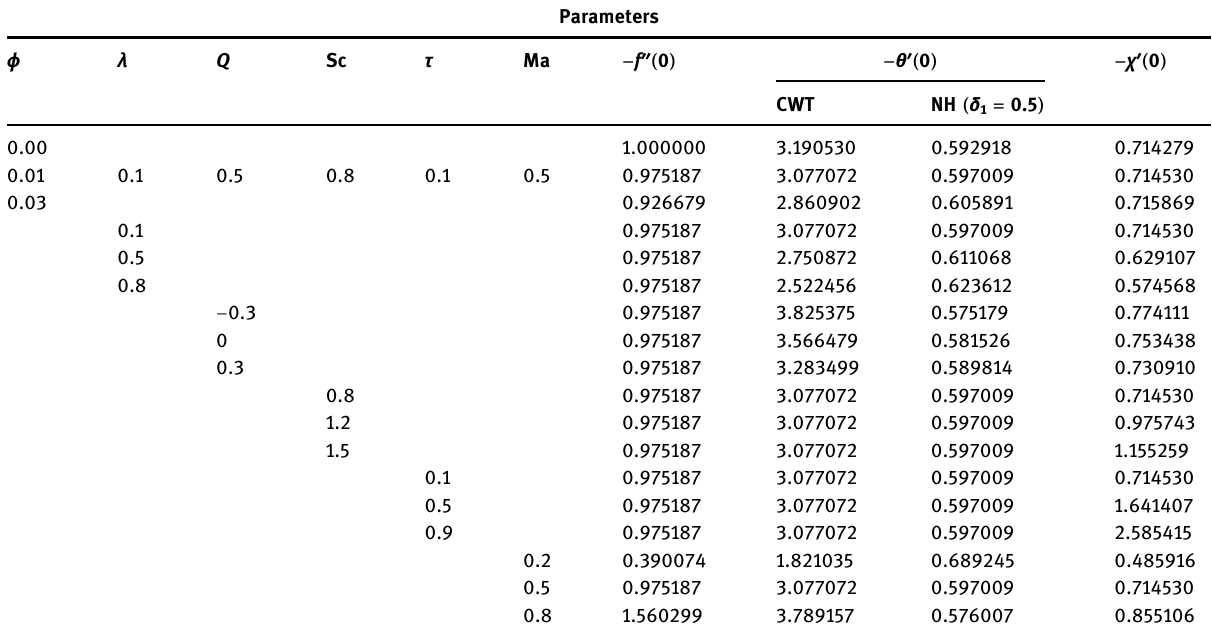
Table 5: Computational values of − f ″ ( 0 ) , − θ ′ ( 0 ) , and χ ′ ( 0 ) various dimensionless parameters